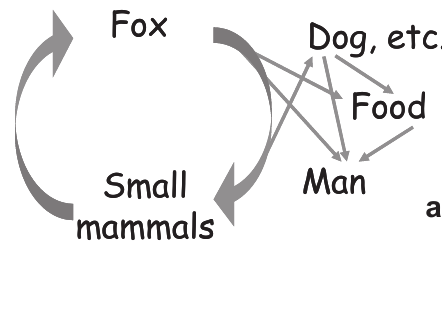
Fig. 3. – Evolution of E. multilocularis transmis- sion picturing. The “classical” parasitological cycle of the 90s (a) has shifted to a more complex box system explicitly featuring population and ecolo- gical direct and indirect processes governing transmission (b). Adding an explicit reference to the nested hierarchy of spatial scales at which various processes occur (c) makes the conceptual model much more complex, although temporal dimension is not represented. After Giraudoux et al . (2003,